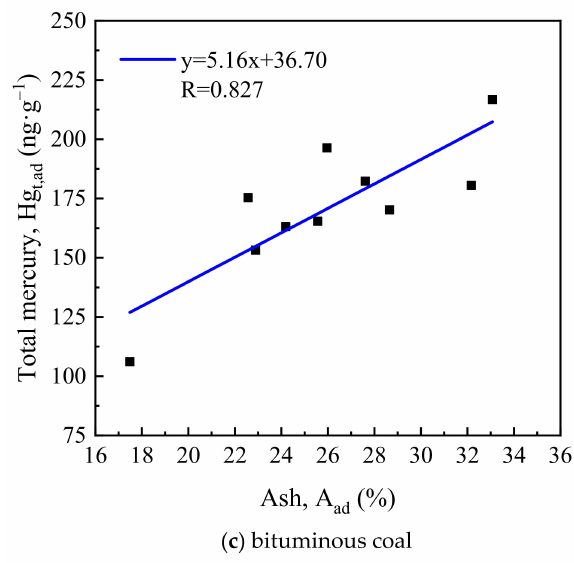
Figure 9. Correlation between Hg and ash for coal samples with different ranks.